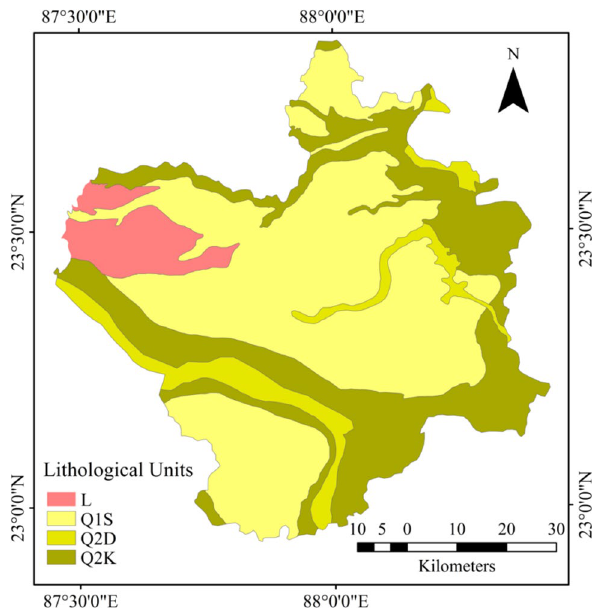
Fig. 3 Lithological map